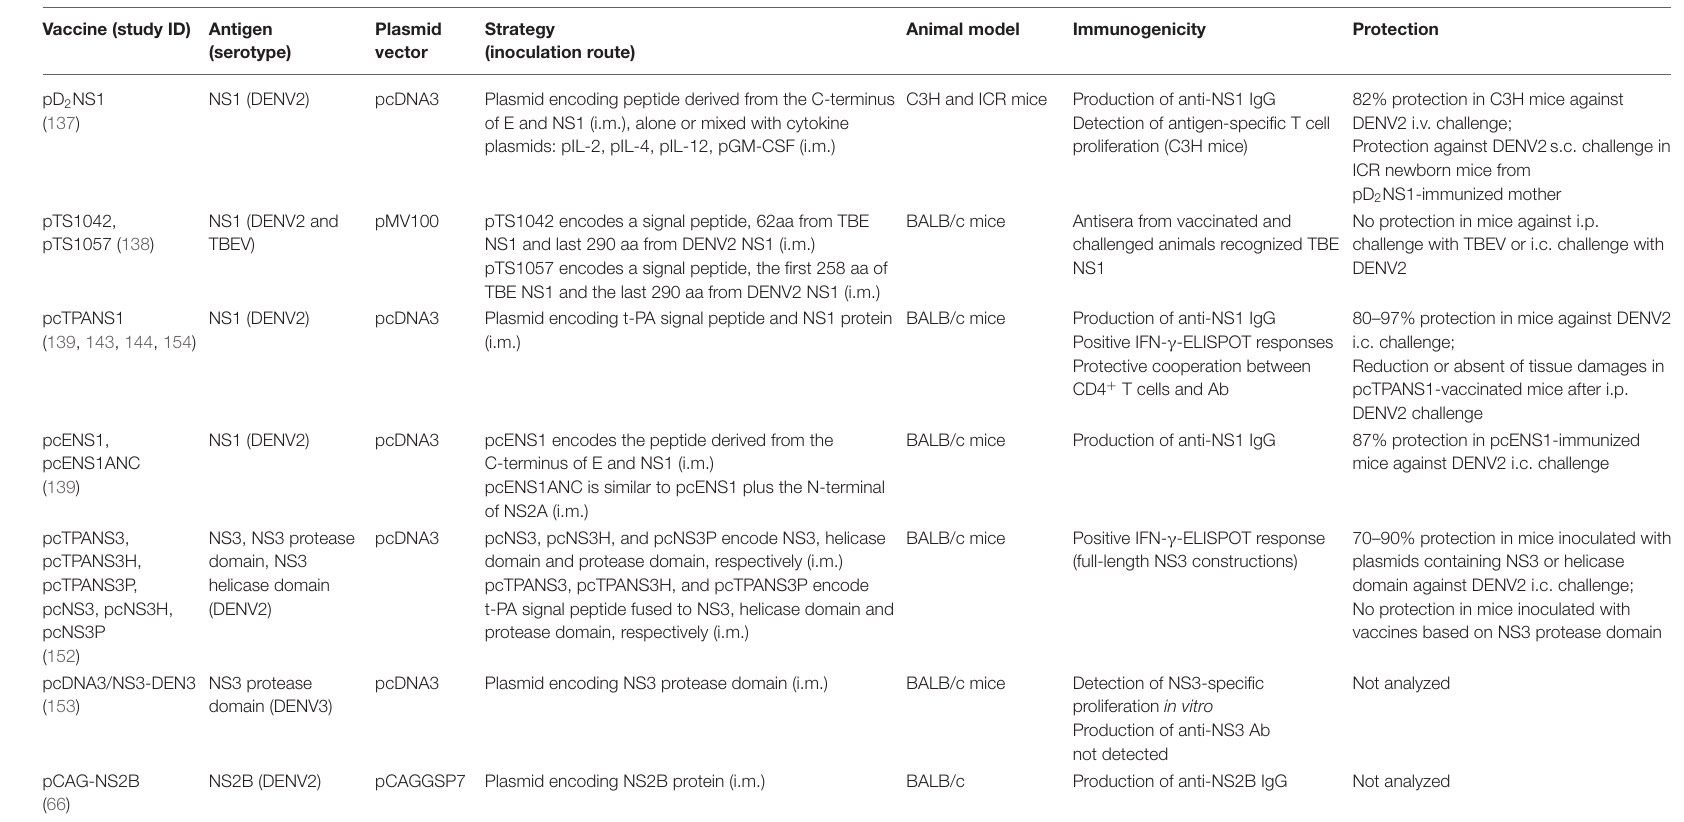
TABLE 2 | DNA vaccines based on dengue non-structural proteins. Vaccine (study ID) Antigen